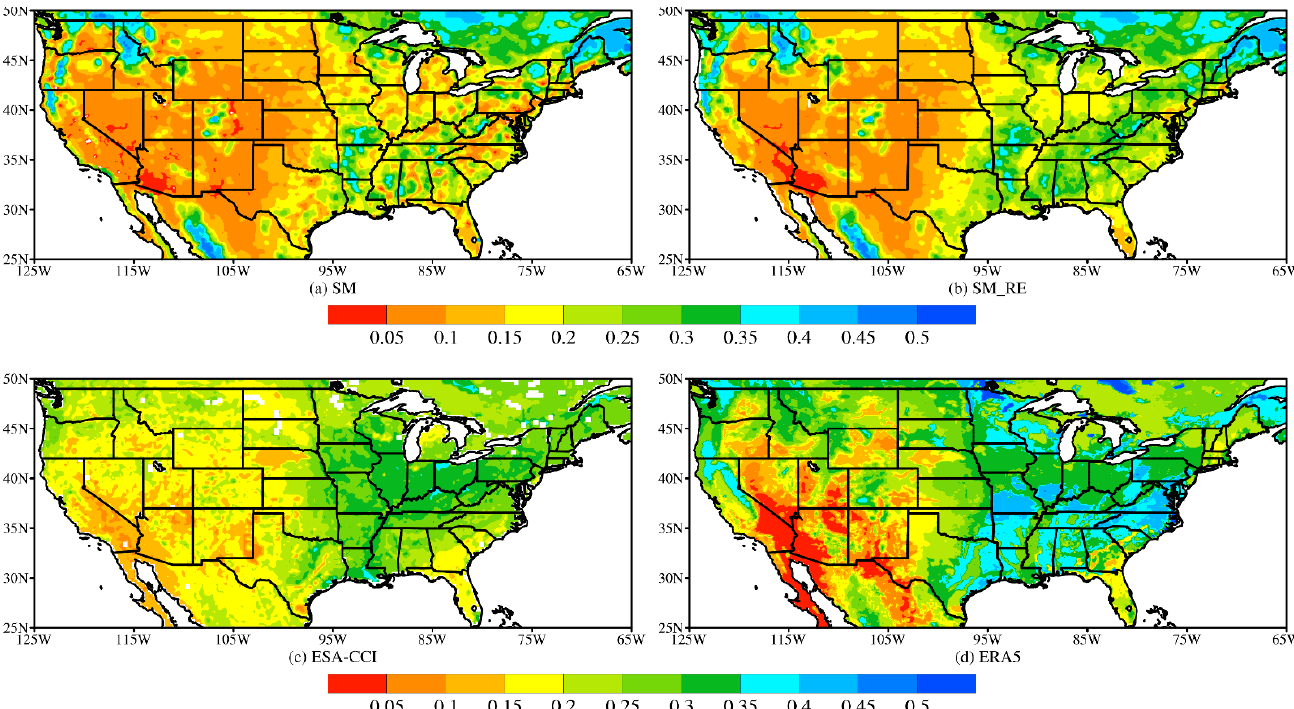
Figure 7. Spatial distribution of the average soil moisture at 6 GHz before restoration ( a ) and at 6 GHz after restoration ( b ) and based on ESA ( c ) and ERA5 reanalysis data ( d ) from March to November 2016 (units: m 3 m − 3 ).